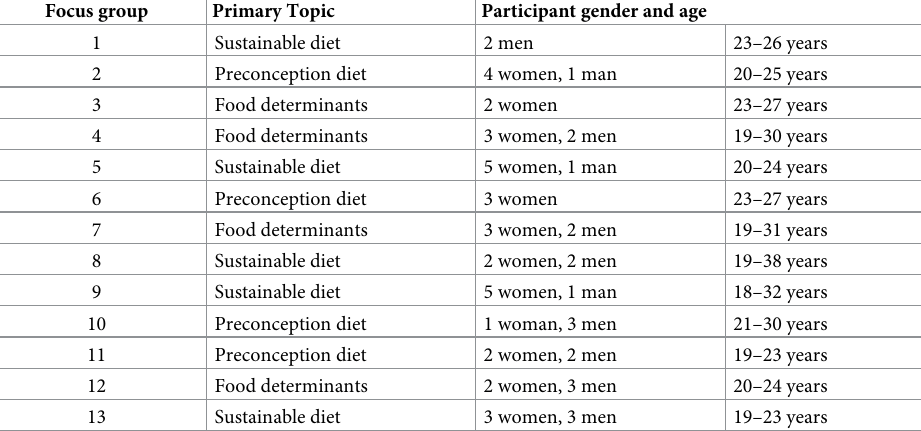
Table 1. Focus group